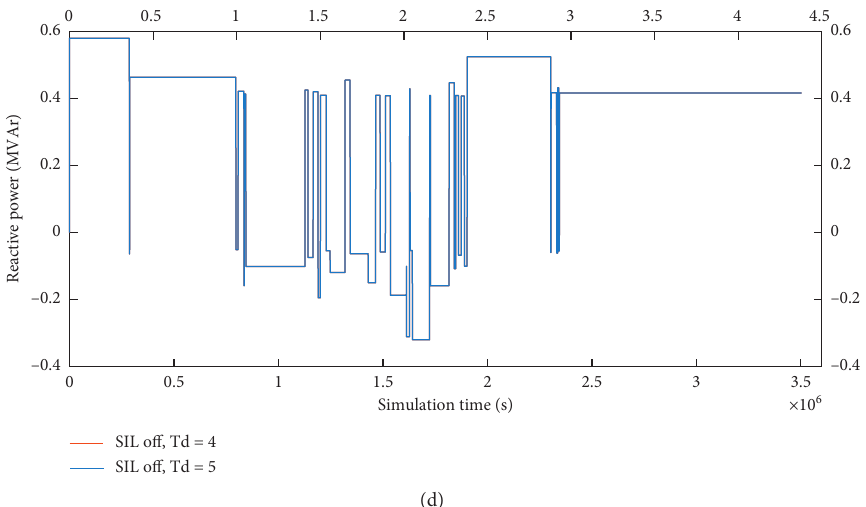
� 0.1 or 1, T � 1 or 10, T � 5 d d d